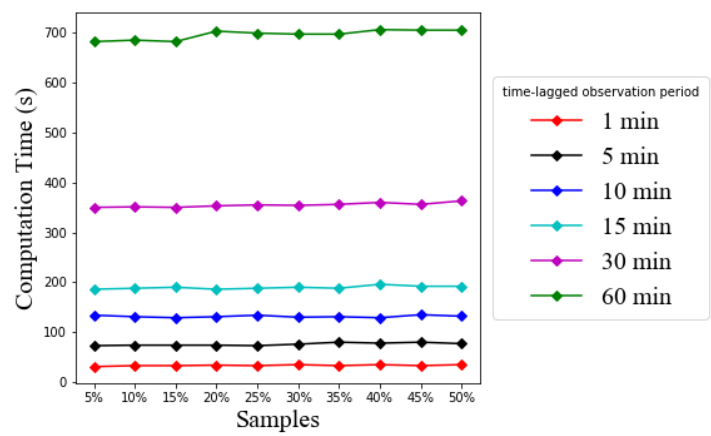
Figure 15. Computation time with varied time-lagged observation